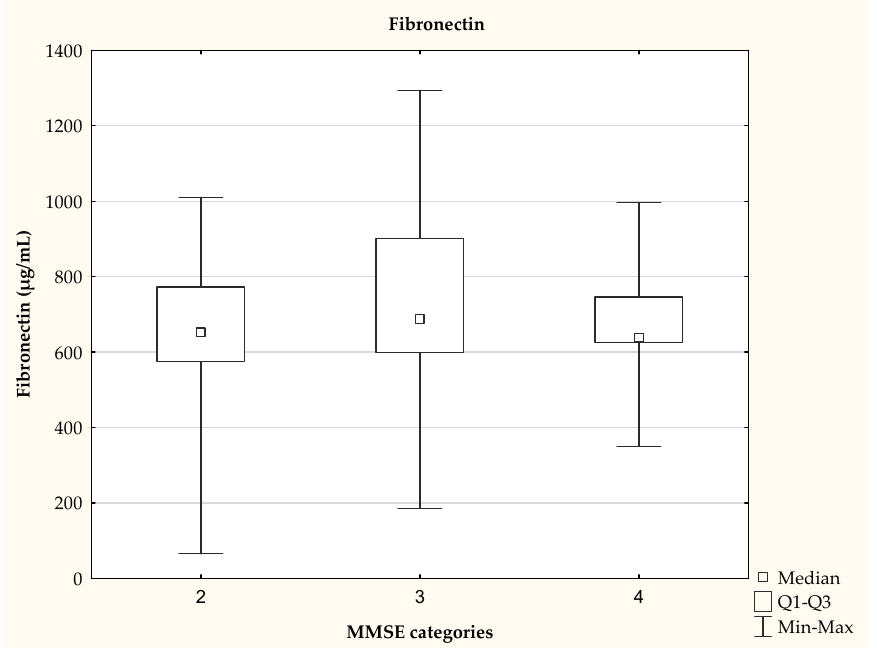
Figure 3. Fibronectin concentration depending on the MMSE category—data presented as medians, no statistically significant differences between groups (Kruskal Wallis test), p > 0.05.